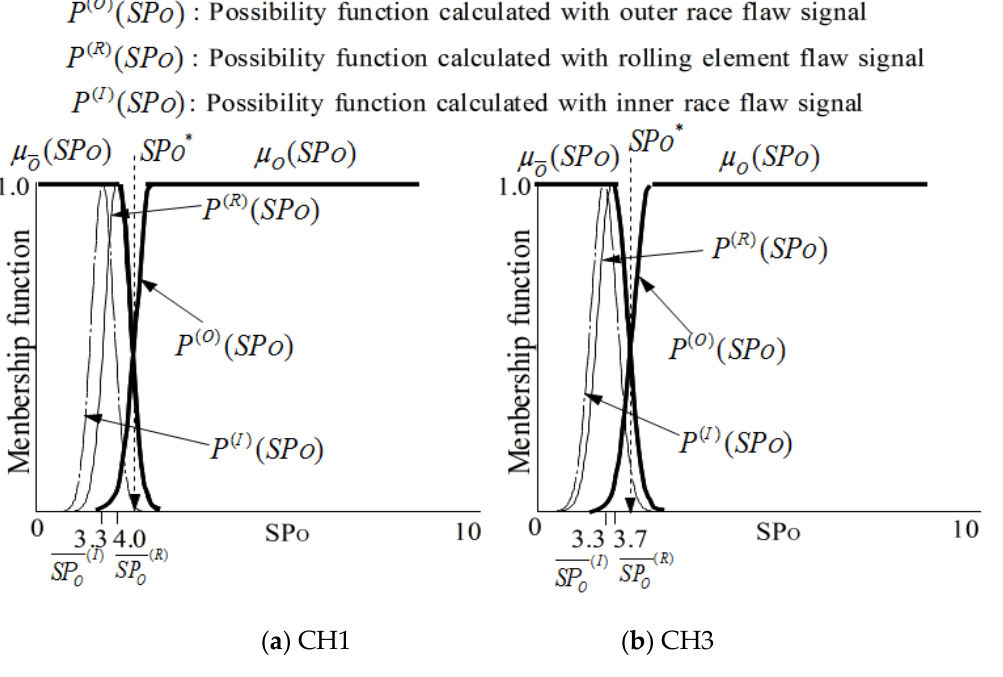
( SP ) for recognition of outer race flaw. O O